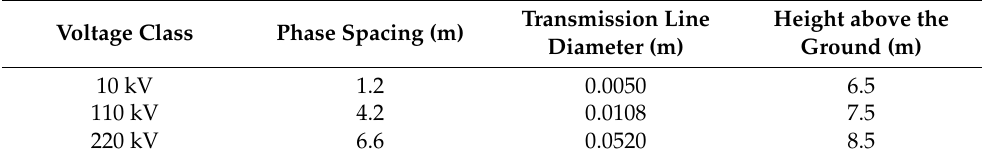
Table 1. Transmission line parameters of different voltage levels.